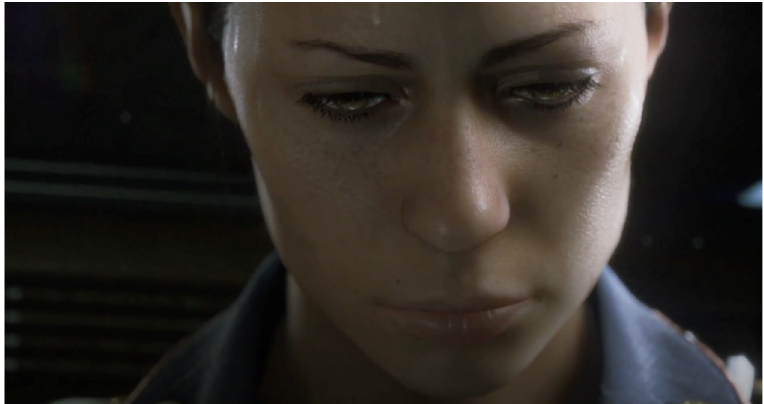
Figure 1. Amanda Ripley’s face expresses empathy-inducing grief as Samuels says, “Maybe there’ll be some closure for you.”